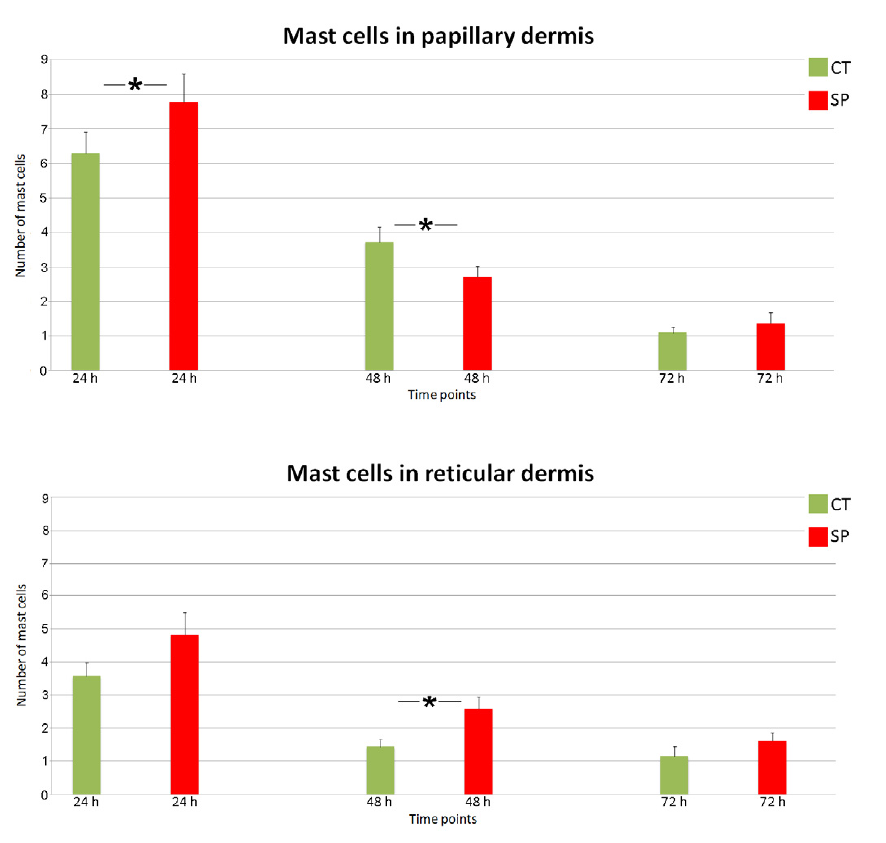
Figure 12. Mean ± standard error values of mast cell number in papillary and reticular dermis. As- terisks indicate signi fi cant di ff erence. In papillary dermis: 24 h CT vs. 24 h SP, p = 0.015; 48 h CT vs. 48 h SP, p = 0.017). In reticular dermis: 48 h CT vs. 48 h SP, p = 0.035. CT, control (untreated); SP, substance P-treated. Macrophages, identified immunohistochemically by the anti-CD68 antibody, showed a significant increase in the papillary dermis of the treated samples after 24 h and 48 h, whereas no significant change was found in the reticular dermis (Figure 13). Statistical comparison between samples at T0 (papillary T0 = 3.60 ± 0.52; reticular T0 = 2.61 ± 0.27; mean ± standard error) and the control samples revealed no significant difference at any time points.